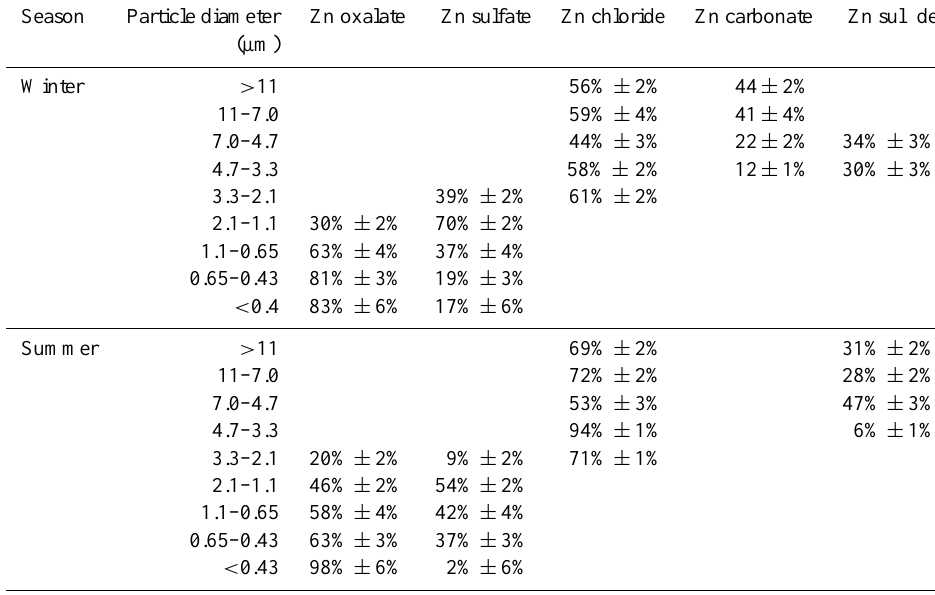
Table 3. Fraction of various Zn species at Tsukuba in winter and summer determined by XANES fitting (mol%). Season Particle diameter Zn oxalate